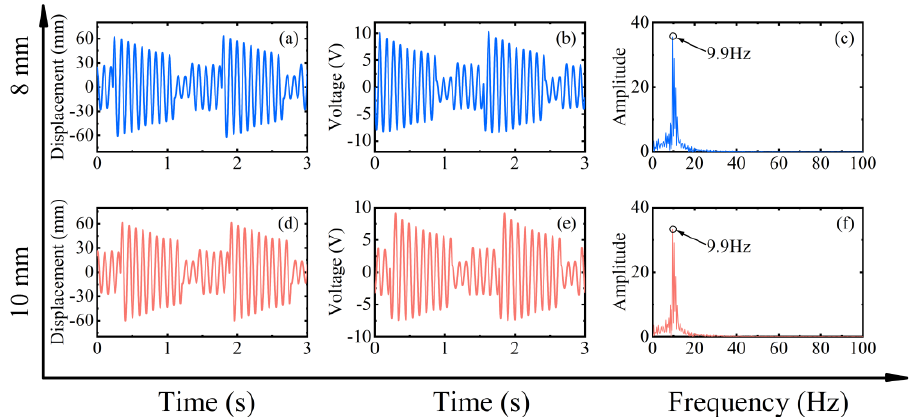
1000 KΩ Figure 12. Simulation results of RMS voltage for the inverse beam at magnet spacing of 8 mm (blue line) and 10 mm (red line). Figures 13 and 14 show the displacement, voltage, and spectrum at 90 rpm (4.5 Hz) and 400 rpm (20 Hz), respectively. The simulation results also show both up-conversion and down-conversion mechanisms of the energy harvester. This gives it a good energy harvesting efficiency at low frequencies while maintaining a certain energy harvesting